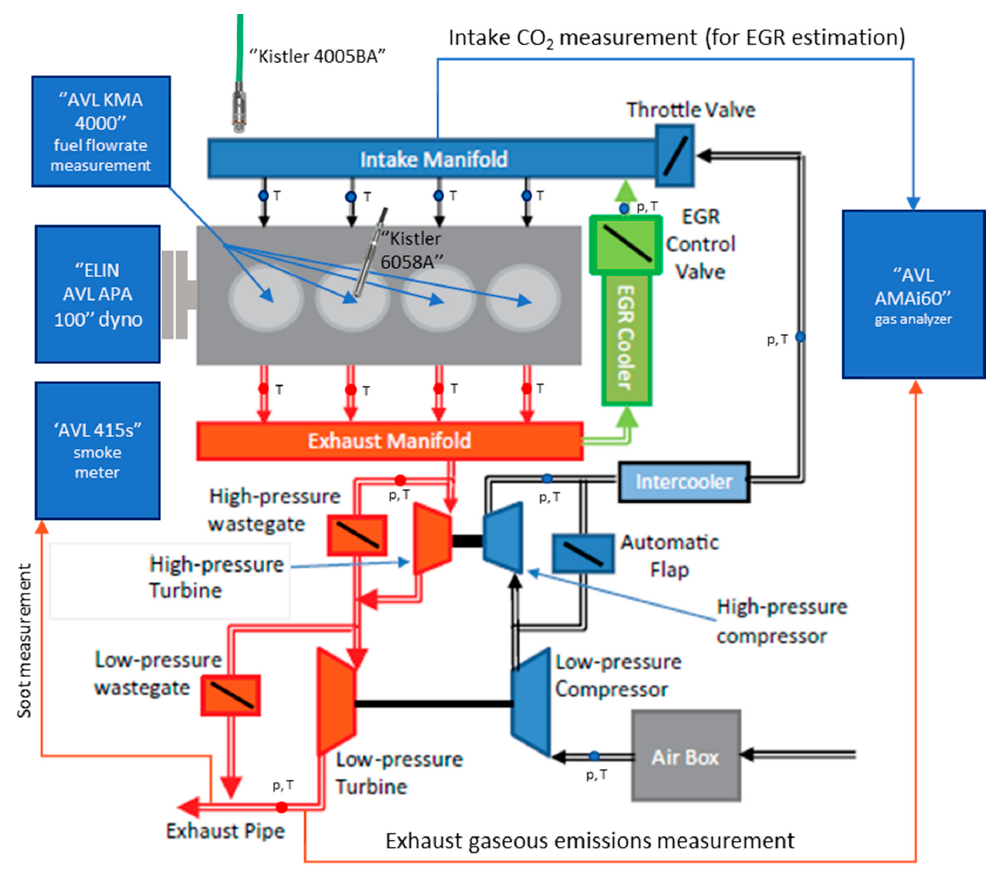
Figure 1. Scheme of the tested engine installed on the dynamic test bench at the Politecnico di